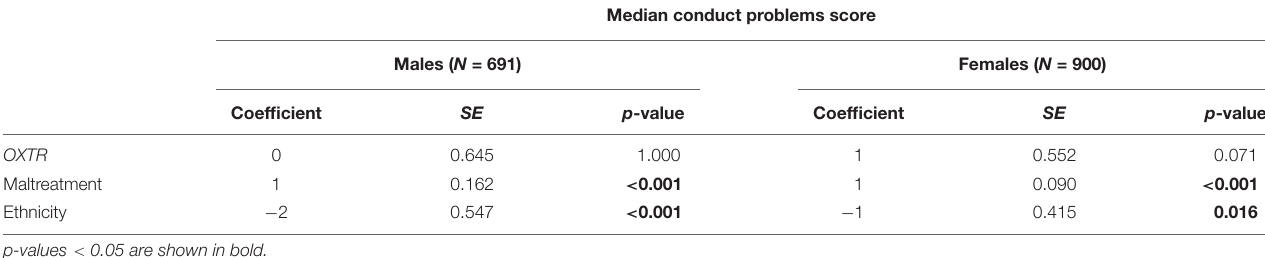
TABLE 3 | Results of median regression of the associations of median conduct problems score with OXTR rs53576, maltreatment, and ethnicity among males and females.